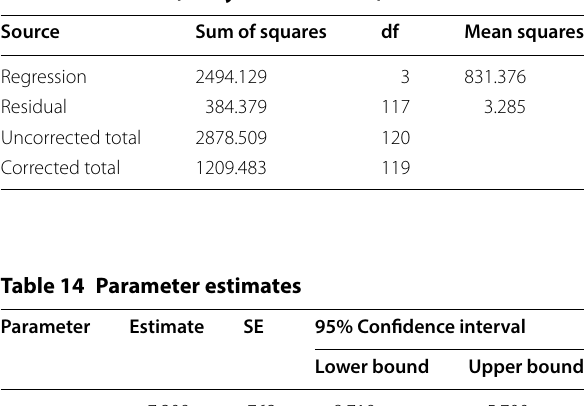
Table 13 ANOVA (analysis of variance)